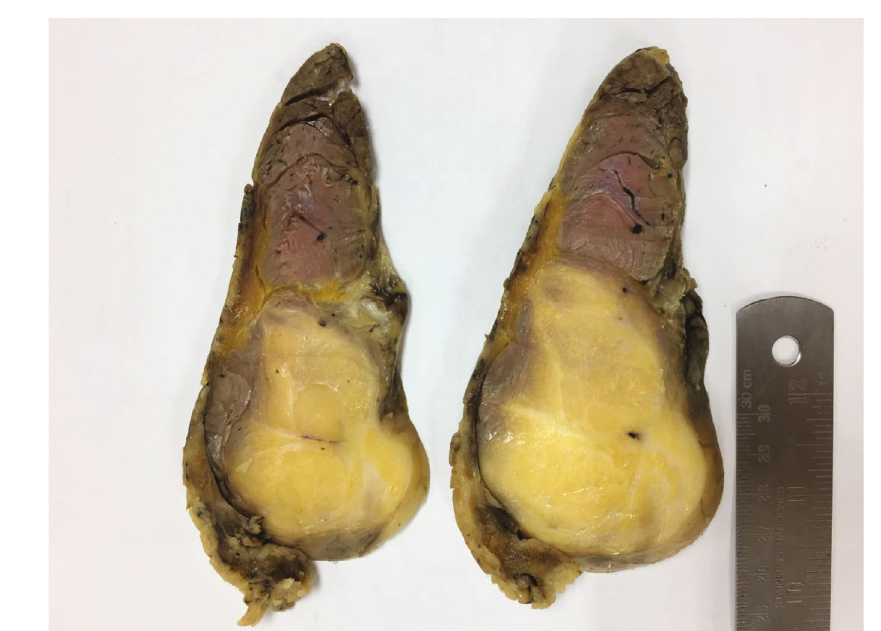
Figure 4: The gross specimen showed cut surfaces of the mass revealing pale yellow, greasy, lobulated mass with ill-de fi ned, in fi ltrative edge to the surrounding muscle on one